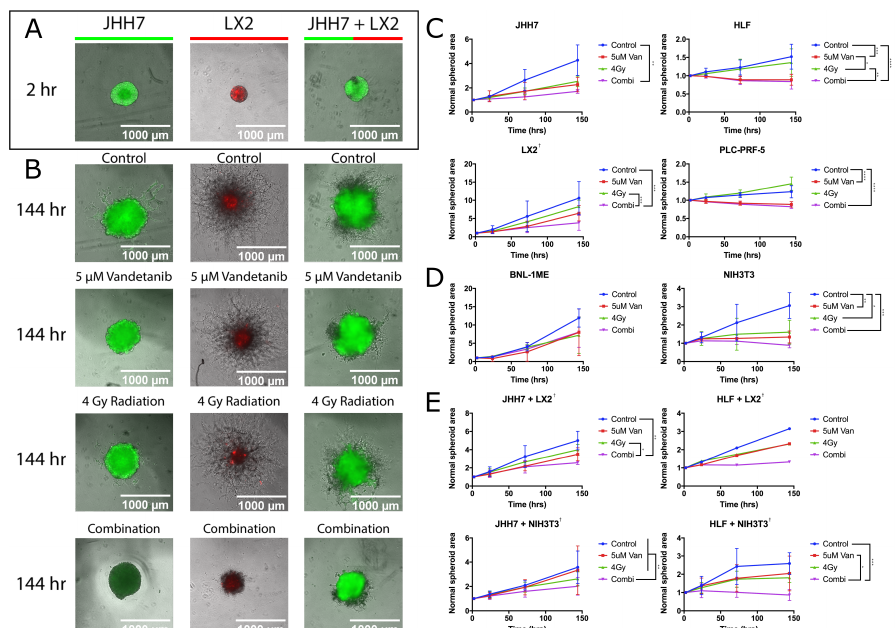
Figure 5. Vandetanib-radiation synergise in 3D spheroid model. HCC cell lines grown in mono-culture and co-culture 3D spheroids. ( A , B ) JHH7 cells fluorescently labelled green, LX2 cells fluorescently labelled red. ( A ) Reference photo of a typical time-point 0 spheroid for comparison. ( B ) Final time-point for each treatment including combination and control. ( C ) Charts depicting growth for mono-culture human spheroids. ( D ) Charts depicting growth for mono-culture murine spheroids ( E ). Charts depicting growth for co-culture spheroids. Eight models demonstrated significance, and LX2 and all co-culture models demonstrated synergy; 2-Way ANOVA * p ≤ 0.05, ** p ≤ 0.01, *** p ≤ 0.001, **** p ≤ 0.001. † CDI > 1. Point images of all time-points, cell lines and conditions included in parts ( A , B ) in Supplemental Figure S3. Additional point images for other cell lines also included in Supplemental Figures S5 and S6.